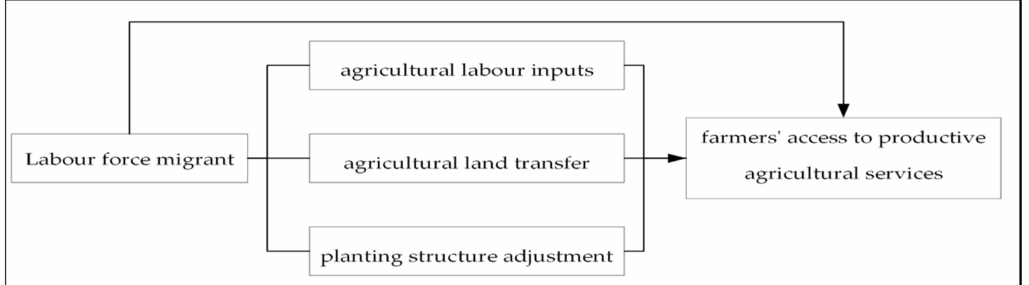
Figure 1. Analysis of the